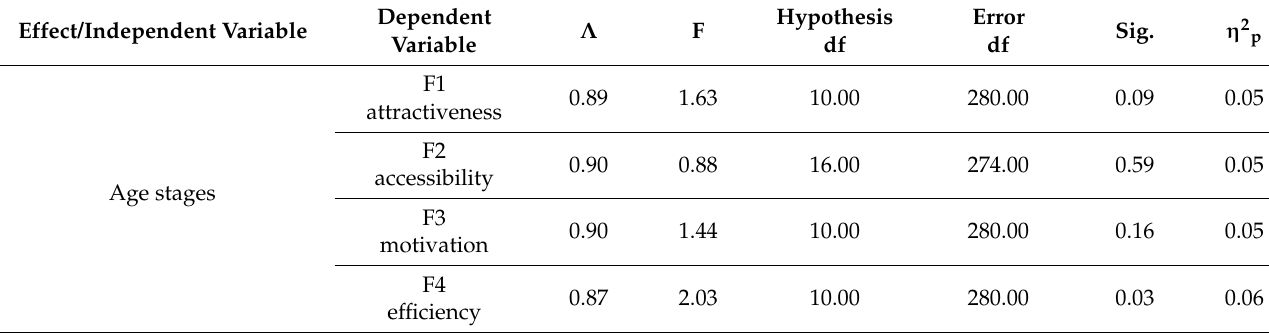
Table 2. The results of the multivariate/MANEUVER analysis at the level of each factor of the questionnaire. Dependent Effect/Independent Variable